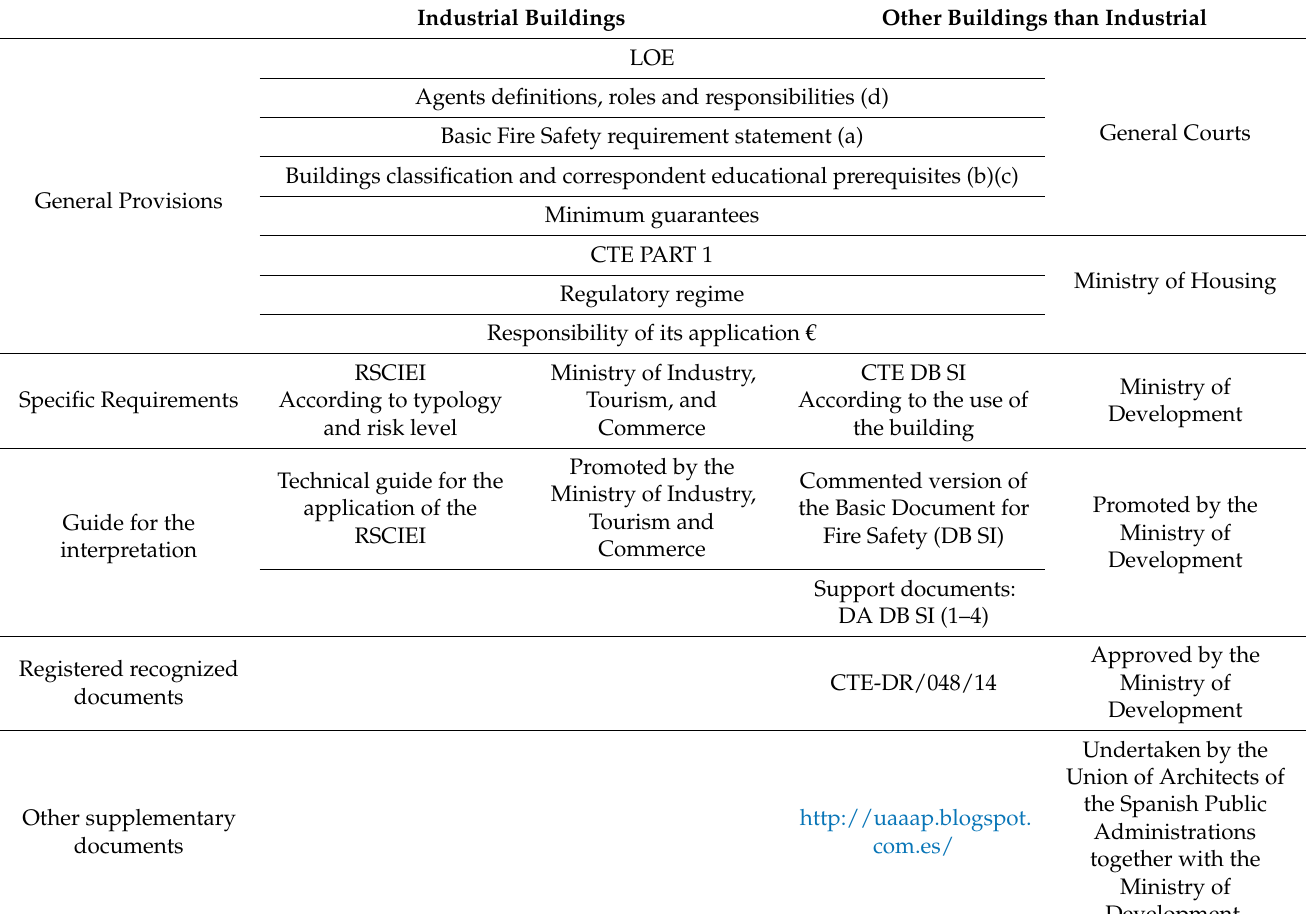
Table 10. Documents of the legal framework containing the provisions for fire safety in Spain